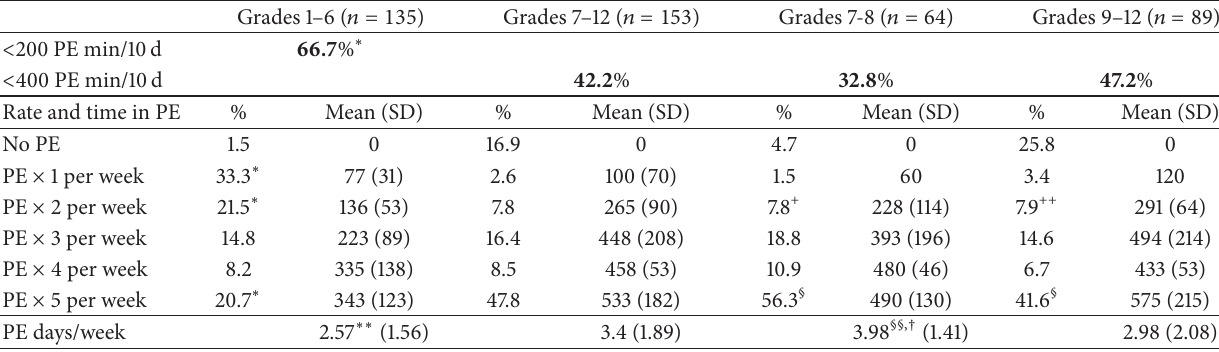
Table 1: Rates of PE, and average time in PE.